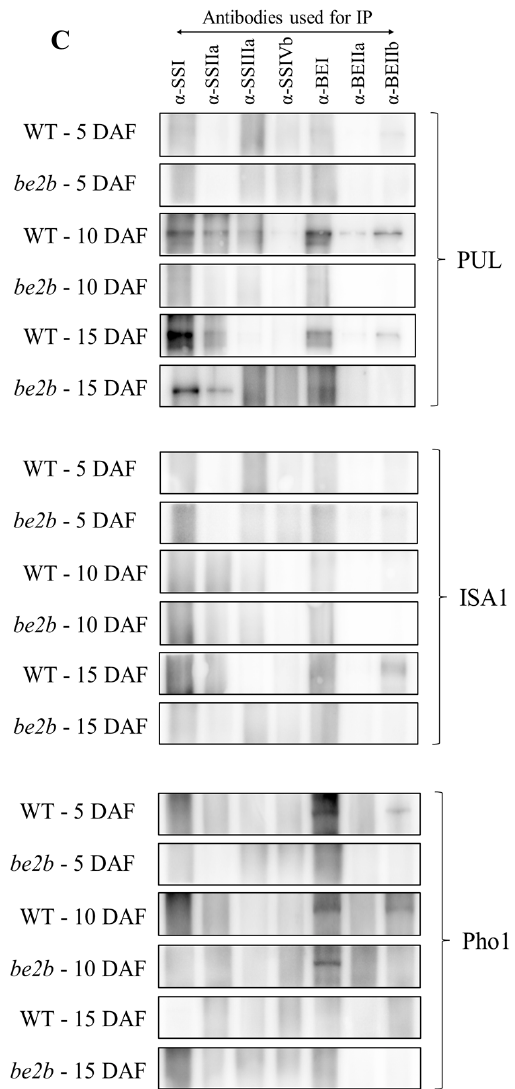
Figure 3. Protein–protein interactions between SSREs during different grain-filling stages (5 DAF, 10 DAF, 15 DAF) in wild type (WT) and be2b mutant by co-immunoprecipitation (Co-IP). Soluble proteins extracted from developing seeds were incubated with the indicated isozyme-specific antibodies and protein A magnetic beads. After washing, the captured proteins were released by boiling in a 1 × SDS buffer and 5 µ L of each supernatant was separated by SDS-PAGE prior to Western blotting. The antibodies used for precipitation as shown in the top panels. The antibodies used for Western blotting are indicated on the right: ( A ) Western blotting of SS isozymes. ( B ) Western blotting of BE isozymes. ( C ) Western blotting of DBE isozymes. Table 1. Comparison of protein-protein interactions among starch synthetic related enzymes during different grain-filling stages (5 DAF, 10 DAF, 15 DAF) in wild type (WT) and be2b mutant endosperms determined by co-immunoprecipitation.